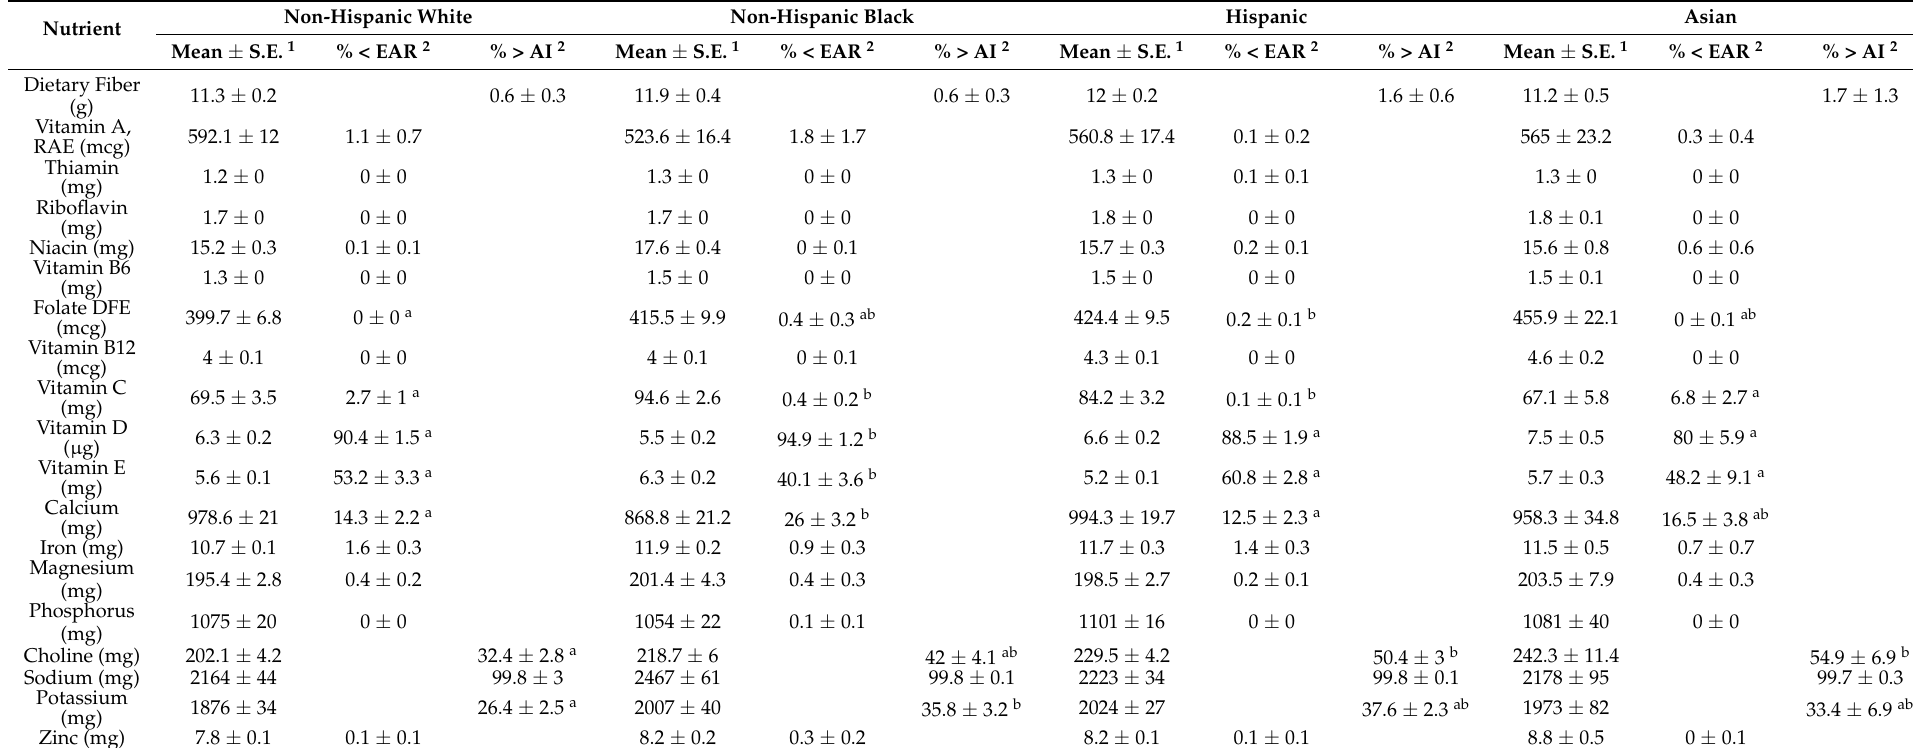
Table 3. Mean nutrient intake of children 1–6 years and proportion not meeting Dietary Reference Intakes by Ethnicity (NHANES